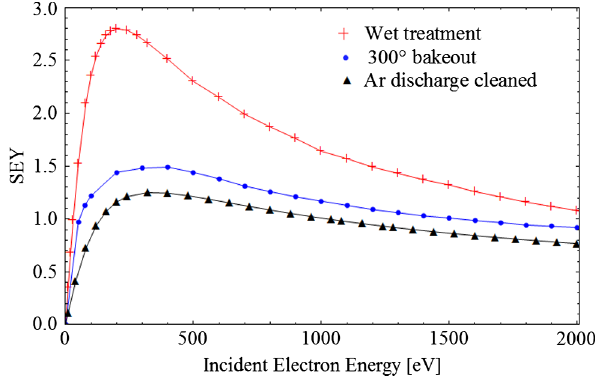
FIG. 2. Secondary emission yield curves for niobium surfaces of